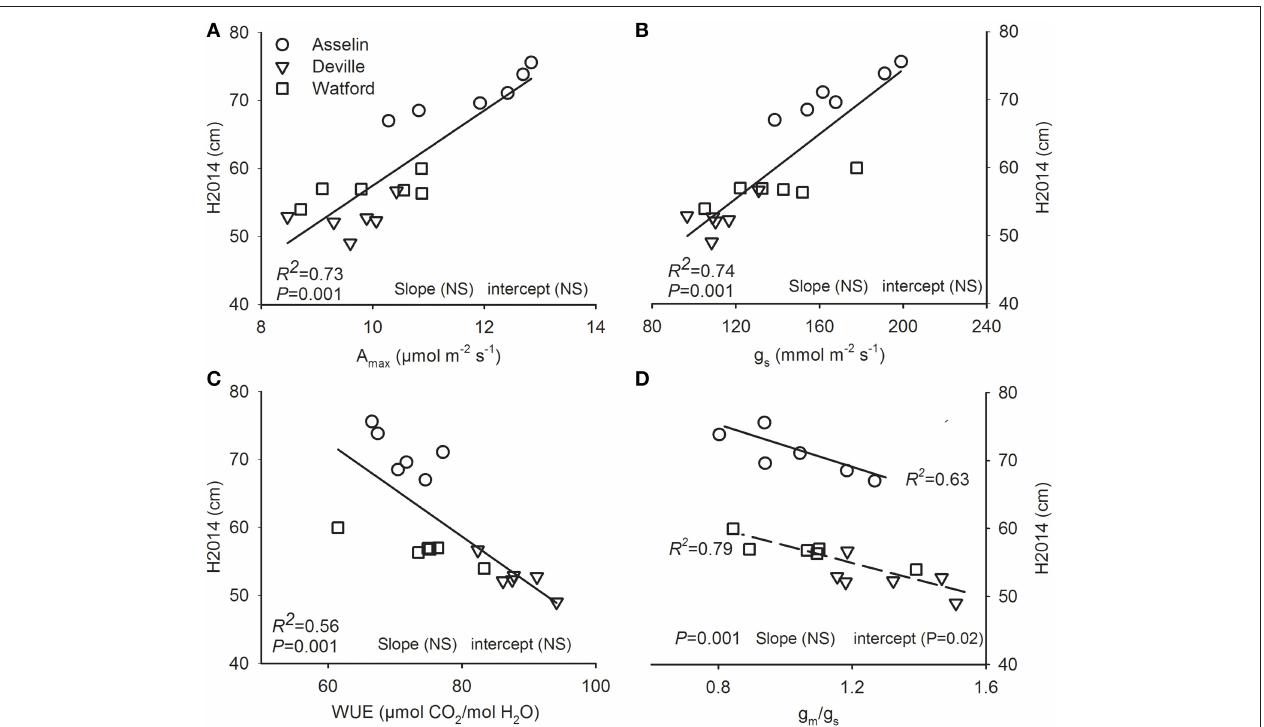
FIGURE 6 | Total height growth at the end of the second growing season (H2014; an index for fitness) plotted against (A) light-saturated photosynthesis on a projected leaf area basis ( A max ) and (B) stomatal conductance ( g s ), (C) water use efficiency (WUE), (D) mesophyll to stomatal conductance ratio ( g m / g s ). Data points are seed source-specific mean value at each site ( n = 18 ). The strength of relationships is indicated by the p -value and coefficient of determination. The significant effect of site on slope and intercept of relationships was determined by ANCOVA. Where slope and/or intercept were significantly different, regression line and coefficient of determination are given for each relationships and the P -value is given for the common regression. NS, not significant.